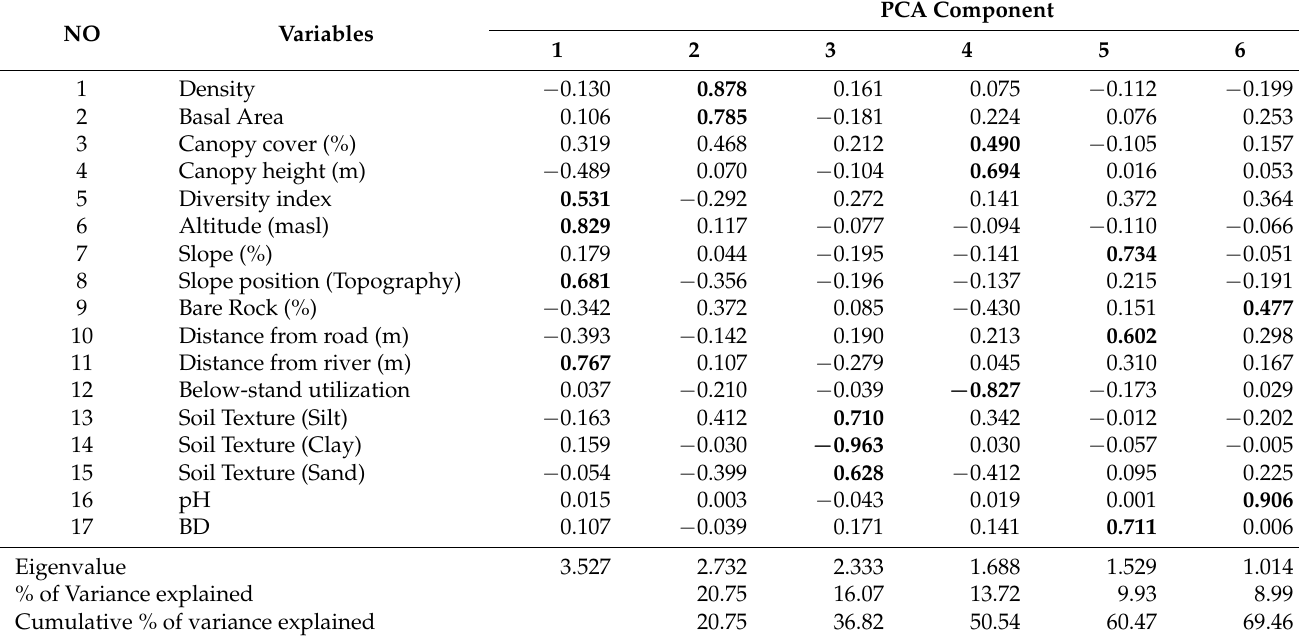
Table 4. Summary statistic of Principal component analysis